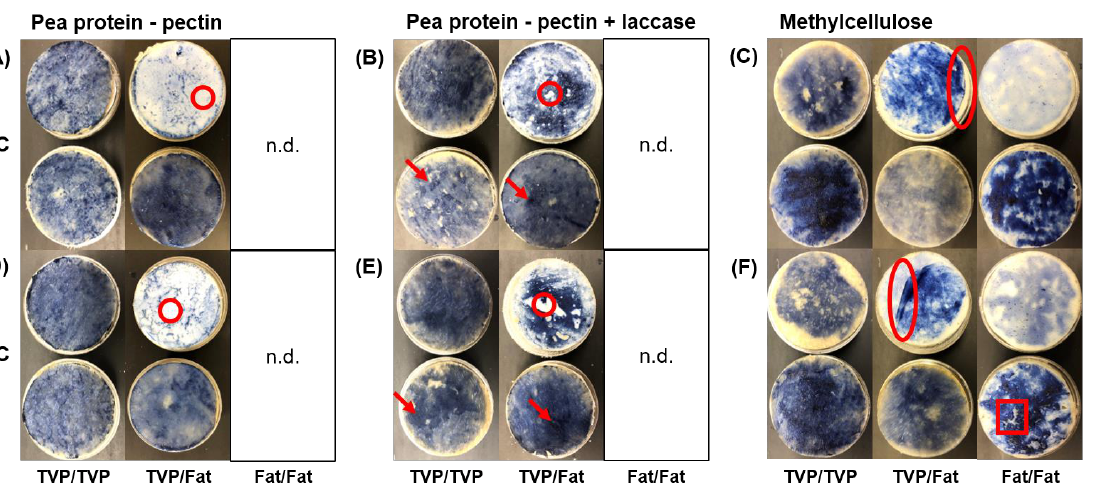
Figure 2. Maximum force and work during a tensile strength test of pea protein–sugar beet pectin mixtures ( r = 2:1, 25% w / w , 100 mM NaCl) without laccase ( A , D ) and with laccase ( B , E ), and methylcellulose hydrogels ( C , F ) acting as binder between textured vegetable protein(s) (TVP) and/or fat mimetic (s) (Fat) at 25 °C and 70 °C. Data points with different small and capital letters denote a statistical difference ( p < 0.05) within each temperature (impact of binder) and within each binder (impact of temperature), respectively. n.d. = not determined due to failure to apply the binder on the fat mimetic directly.